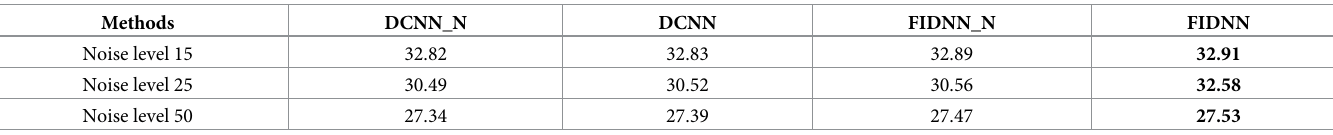
Table 1. Ablation study of denoising on Set12 dataset.